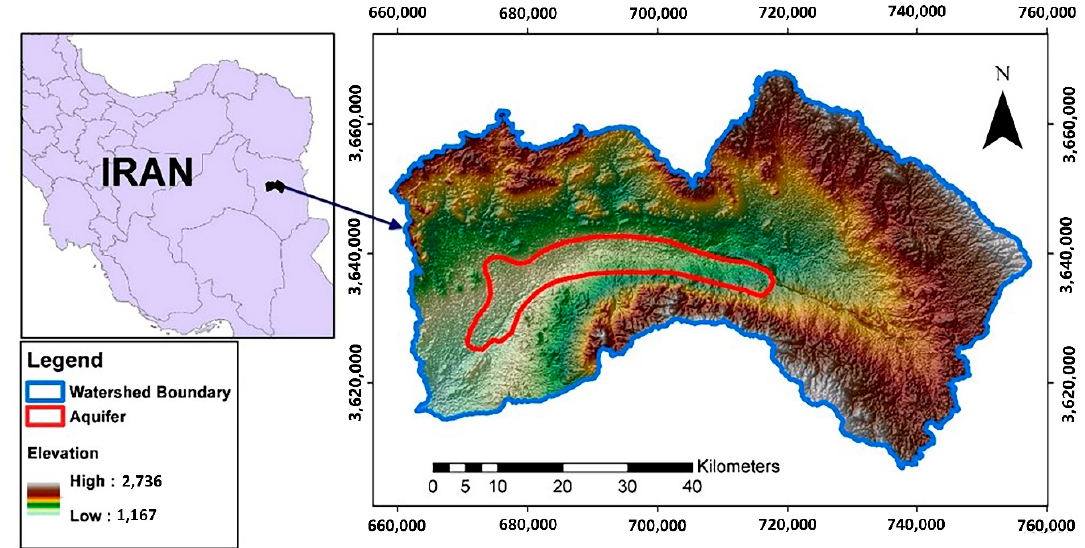
Figure 3. Location of Birjand watershed and Birjand Aquifer in South Khorasan Province, Iran [35].